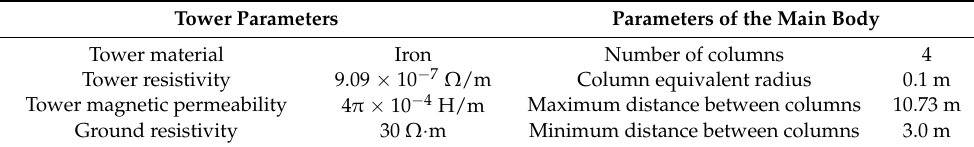
Table 2. Parameters for the multi-surge impedance model. Parameter Name